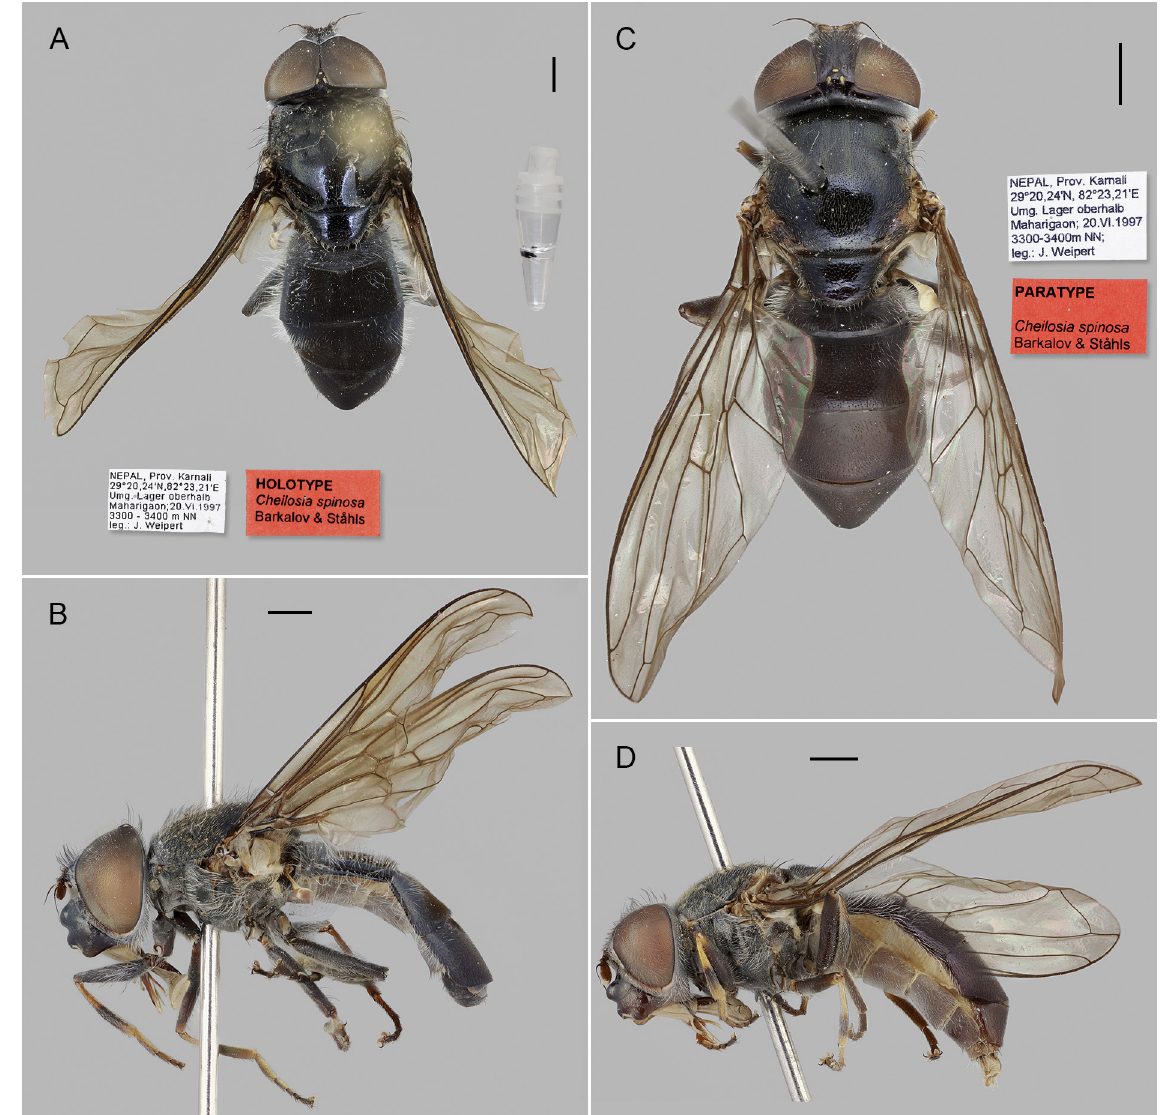
Fig. 59. Cheilosia ( Cheilosia ) spinosa sp. nov. A–B . Holotype, ♂ (BSJW/NME); dorsal and lateral views. C–D . Paratype, ♀ (BSJW/NME), dorsal and lateral views. Photo: Pekka Malinen, FMNH Luomus. Scale bars = 1